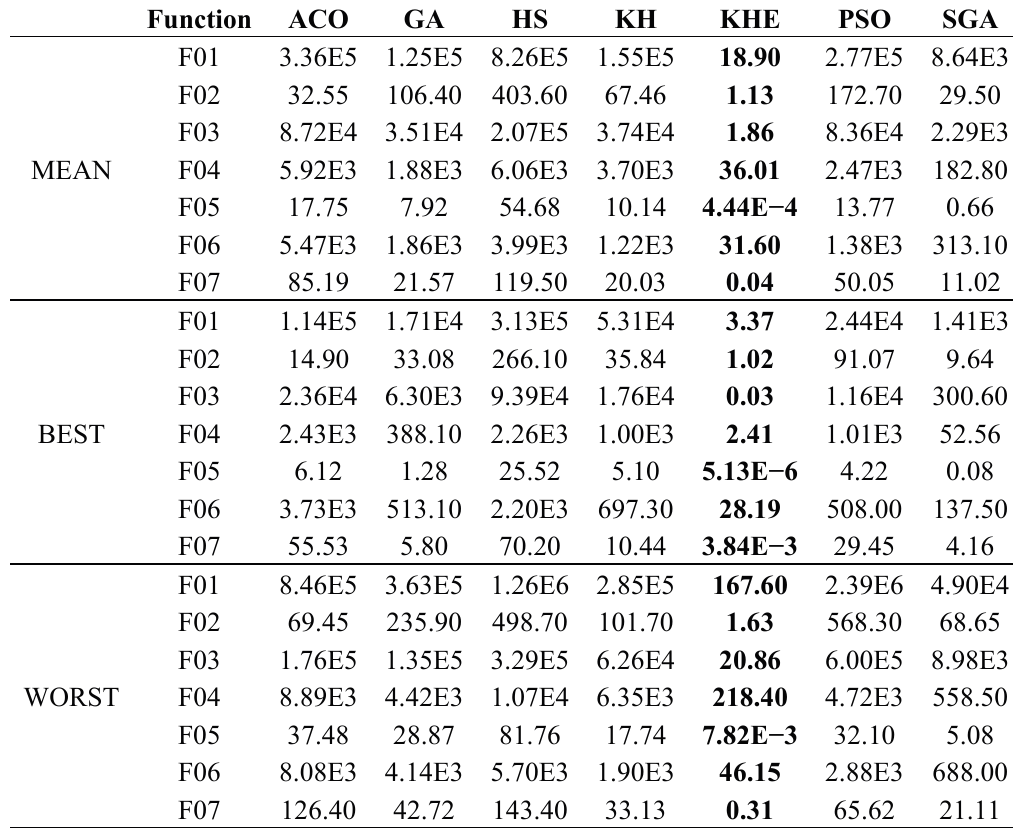
Table 2. Mean, best and worst function values obtained by different